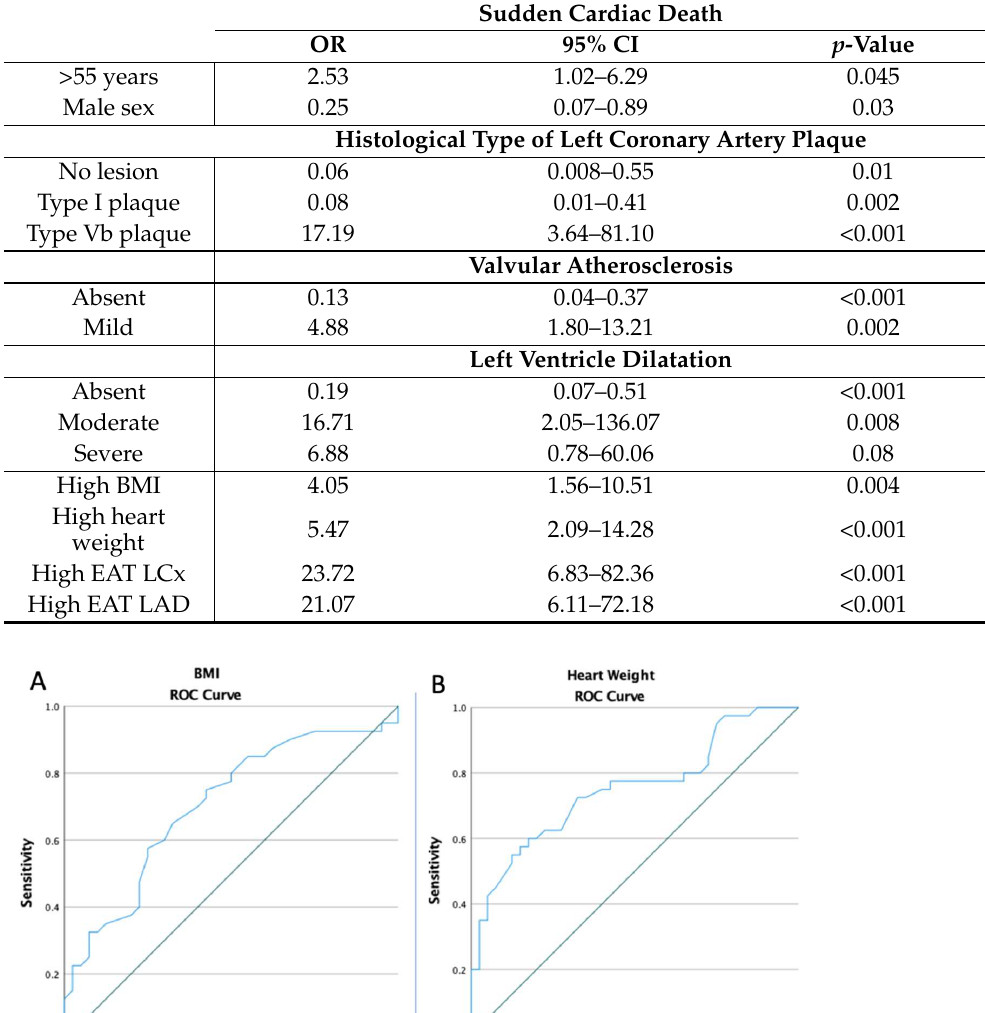
Table 3. Multivariate analysis for predictors of SCD.